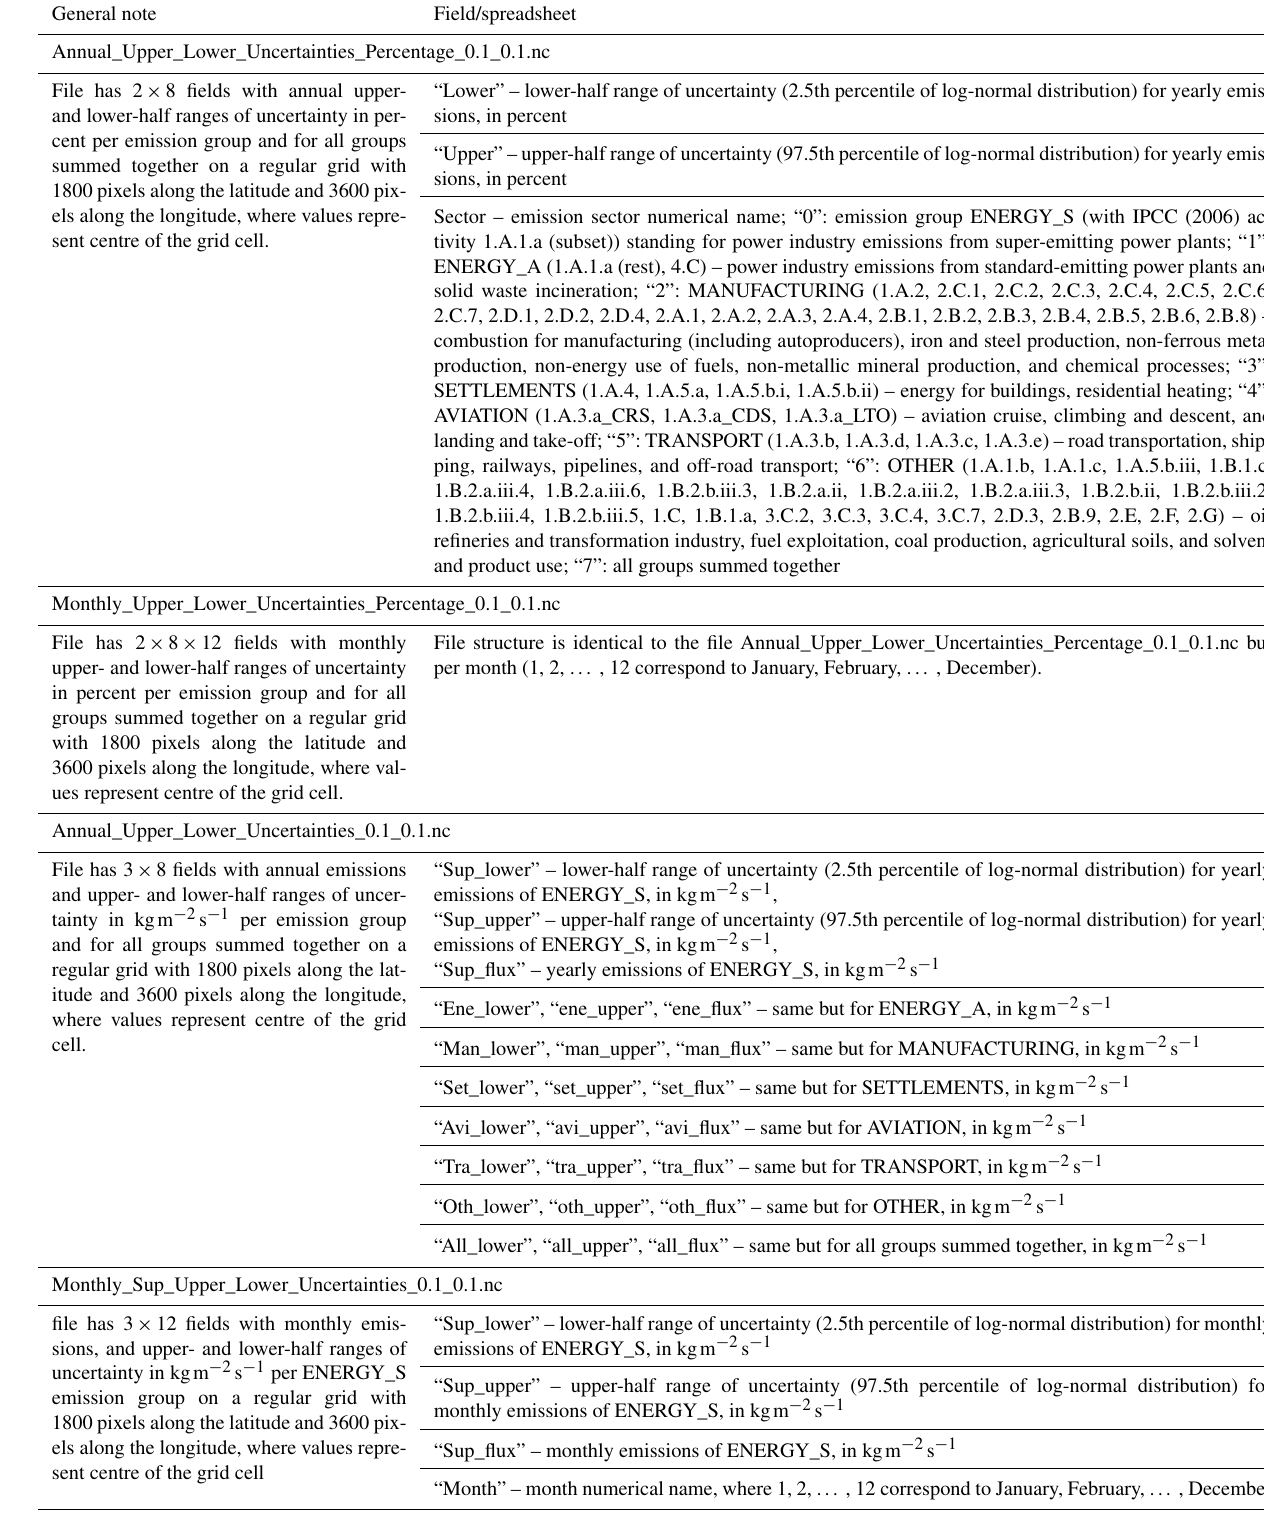
Table 3. Detailed information on CHE_EDGAR-ECMWF_2015 data. General note